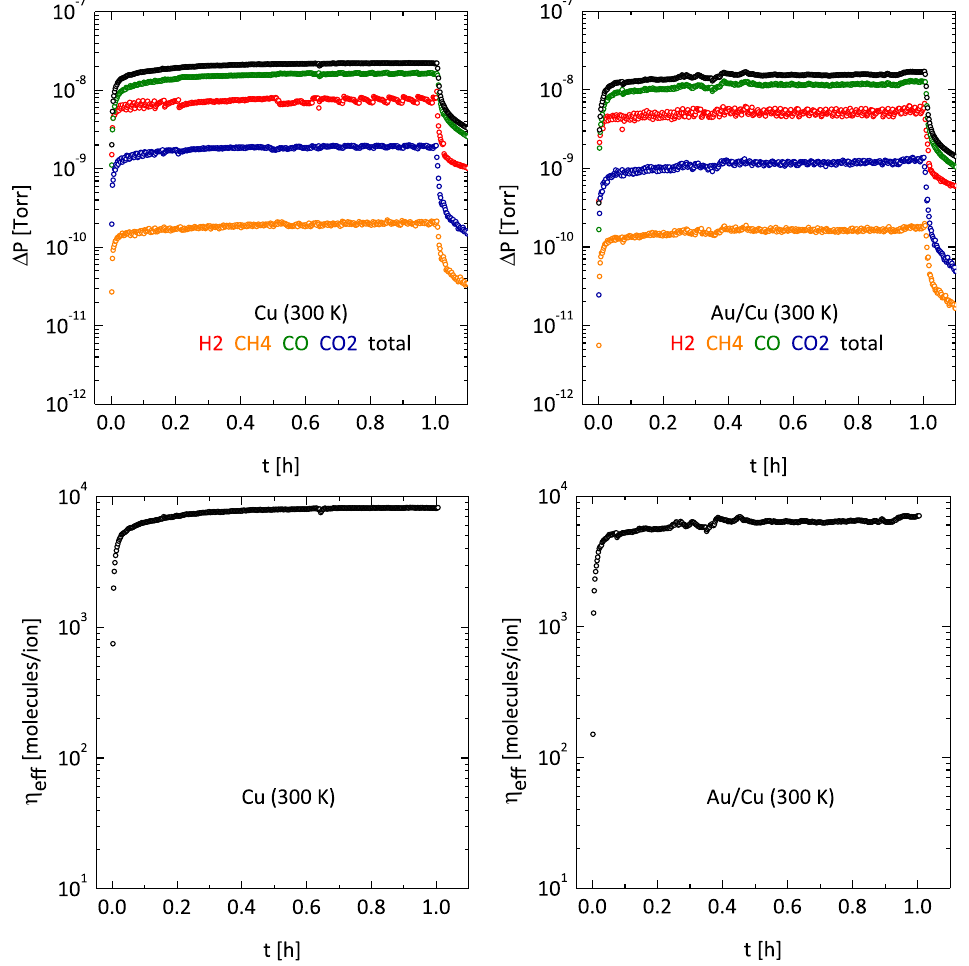
FIG. 2. Heavy-ion-induced gas desorption measurements at 300 K target temperature. Partial pressure rises ( (cid:2) P ) of H 2 , CH 4 , CO, CO 2 , and total pressure measured for bare and gold-coated copper samples continuously bombarded under Pb 54 þ ions are shown together with the corresponding desorption yields ( (cid:2)